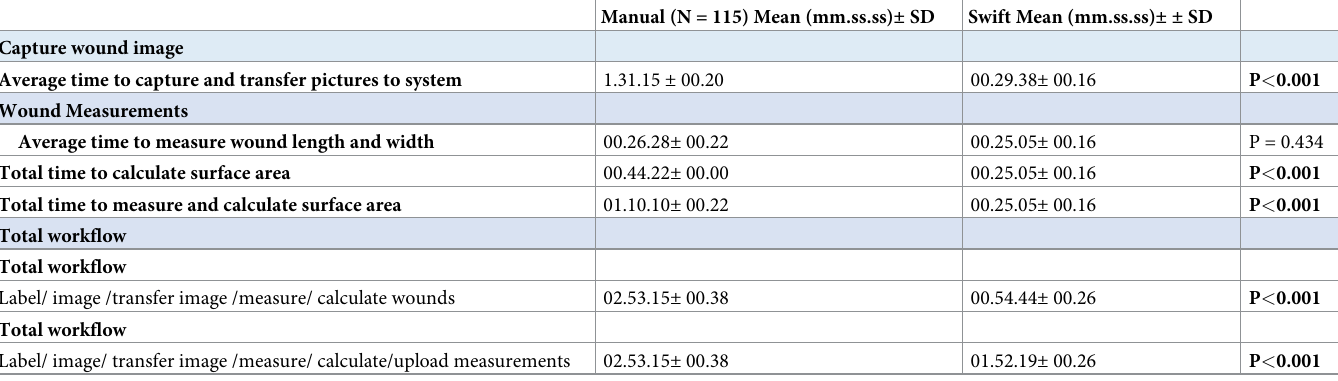
Table 2. Time to successfully complete each activity necessary to evaluate